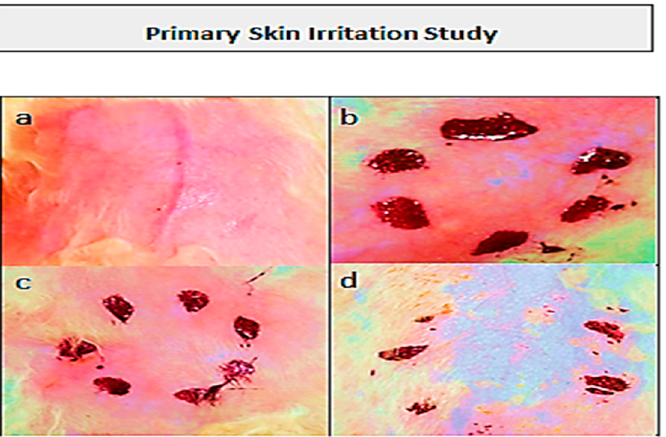
Figure 10. Evaluation of rabbit skin for irritation study ( a ) fresh shaved skin ( b ) after 24 h ( c ) after 48 h, ( d ) after 72 h. 48 h, ( d ) after 72 h. Table 6. Scores of Skin Irritation Study (Mean ± SE) of optimized formulation. Table 6. Scores of Skin Irritation Study (Mean ± SE) of optimized formulation.